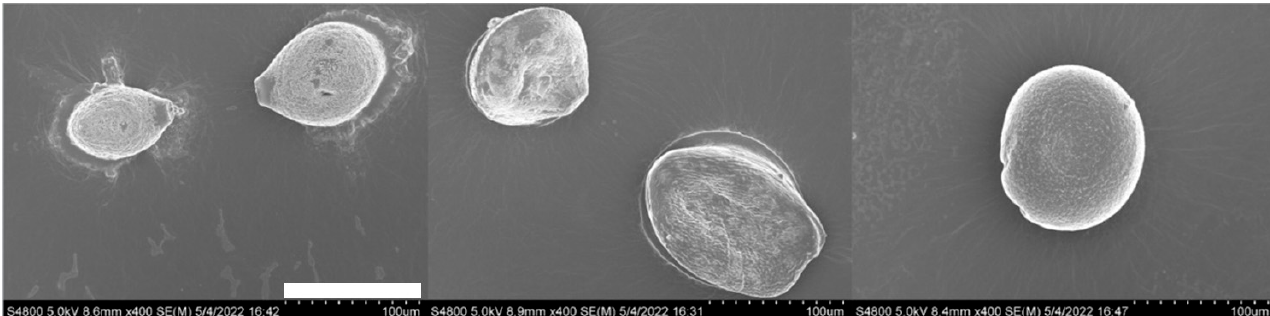
Figure 3. FE ‐ SEM images of PM, EGM, and TGM, from left ‐ right. The scale bar represents 100 μ m. Figure 3. FE-SEM images of PM, EGM, and TGM, from left-right. The scale bar represents 100 µ